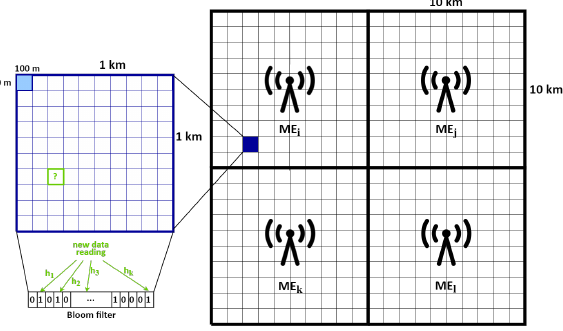
Figure 2. A setup for decentralized energy-efficient MCS from an ME host’s